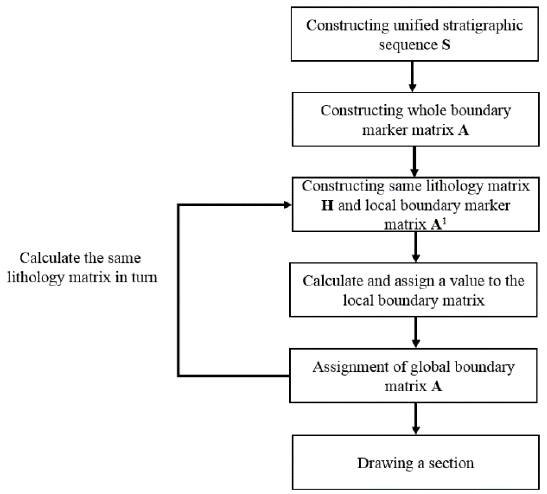
Figure 4. Steps for drawing a pinch-out profile based on a unified stratigraphic sequence.